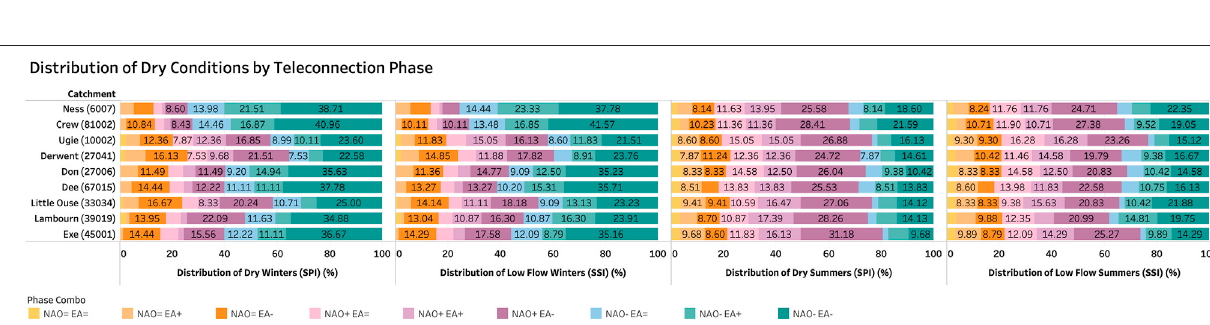
Frontiers in Environmental Science |